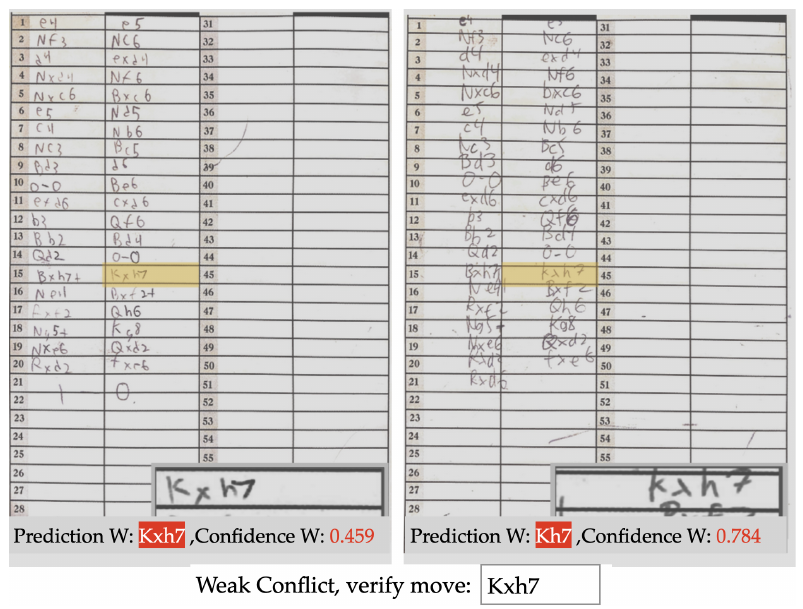
Figure 9. The semi-autonomous user interface, displaying both scoresheets with the pertinent moves highlighted, along with a zoomed view of the moves and the network's guess for each.